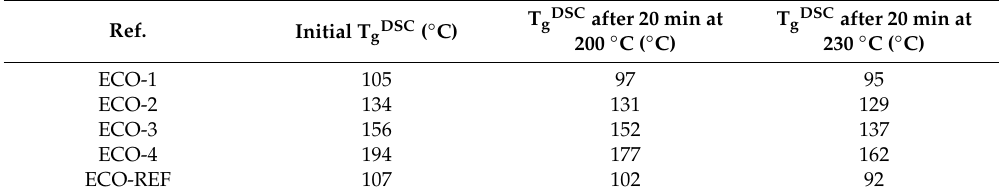
Figure 3. Weight-loss of the prepared samples during the TGA isothermal at: ( a ) 200 ◦ C; and ( b ) 230 ◦ C. Table 4. DSC analysis of the prepared materials before and after the TGA isothermal for 20 min at 200 ◦ C and 230 ◦